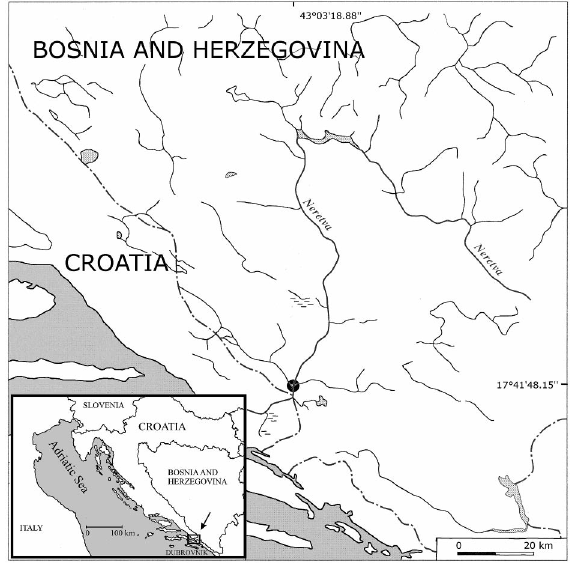
Fig. 2. The Neretva River in Bosnia and Herzegovina with the sampling location (black dot) of the described spec- imen of black-striped pipefish Syngnathus abaster